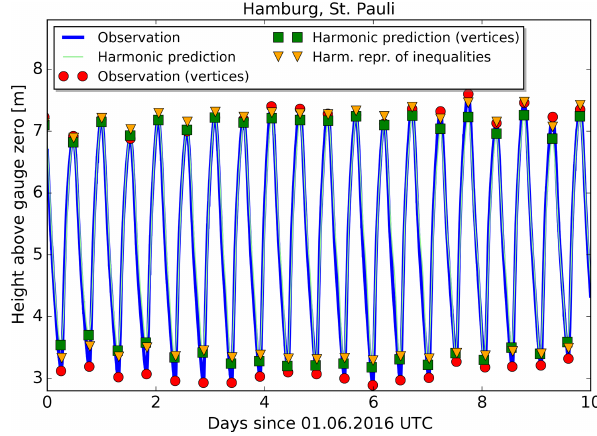
Figure 12. Observations and two predictions for the tide gauge Cux- haven, Steubenhöft. The first 10d of June 2016 are shown.